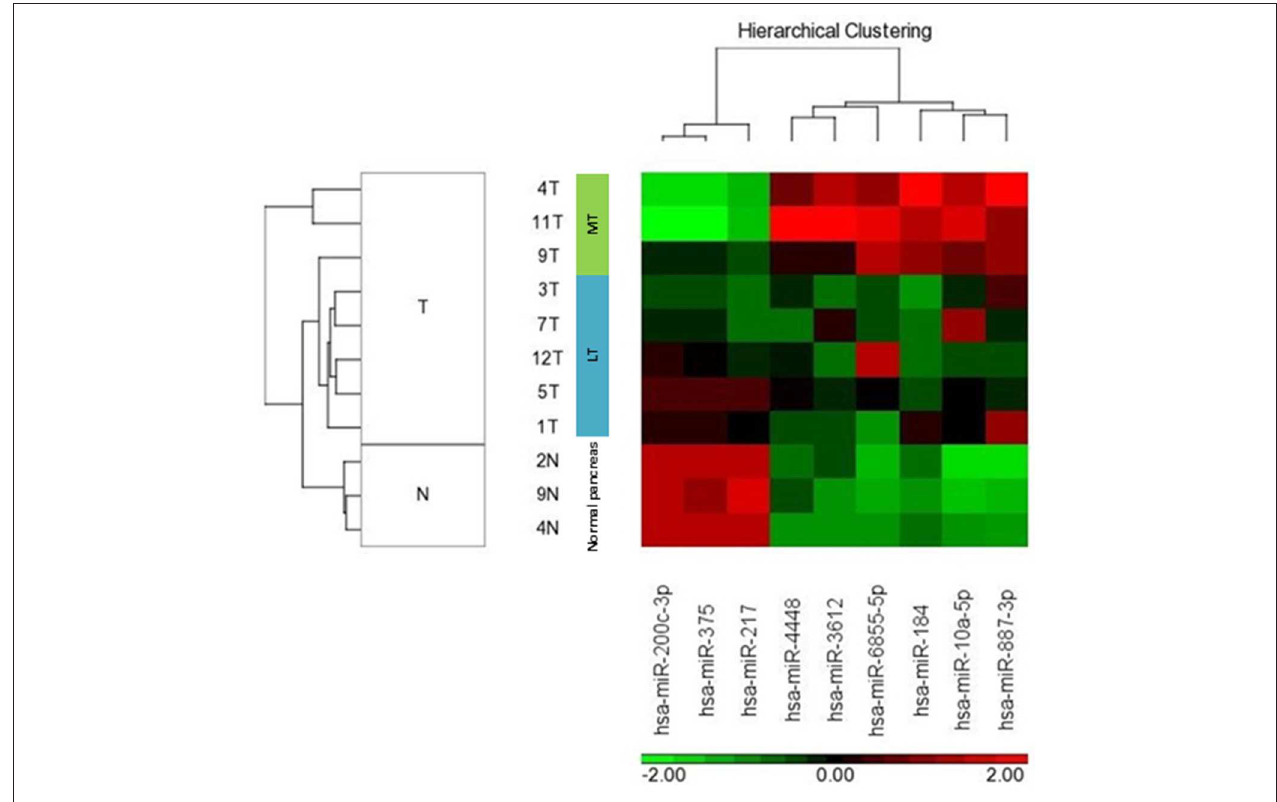
FIGURE 3 | MicroRNA expression of localized and metastatic SPN classified samples. HeatMap and unsupervised clustering schema of 5 localized tumors (LT), 3 metastatic tumors (MT), and 3 normal pancreatic tissues. The normalized expression level (h) of each microRNA is color